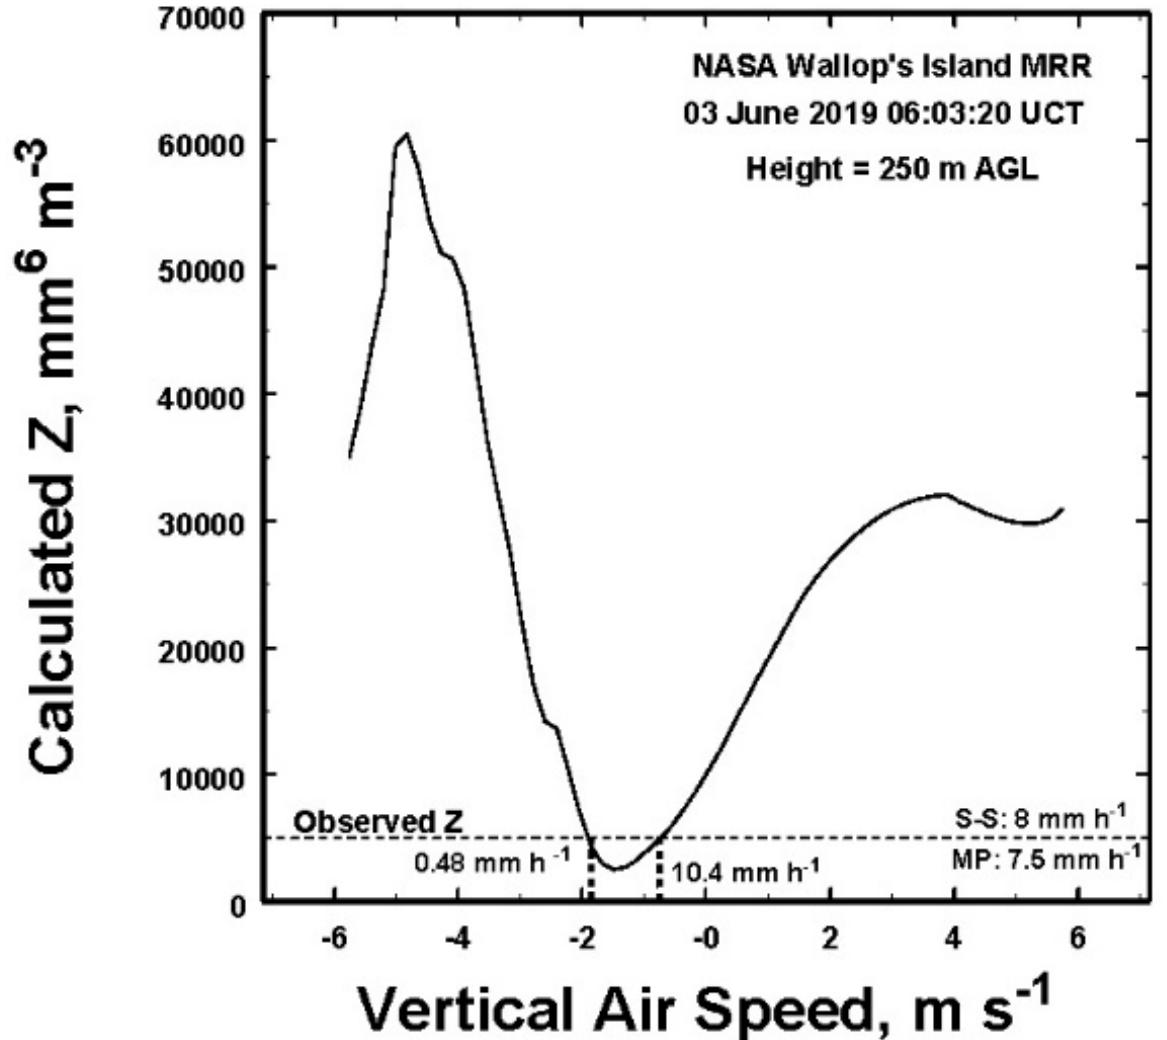
Figure 4. An example of the application of the approach described in the text. The solid line represents the theoretical calculated radar reflectivity (vertical axis) using (10), while the dashed line represents the MRR measured value. There are two solutions for the vertical air velocity, w , one of which is the preferred, as discussed in the text.